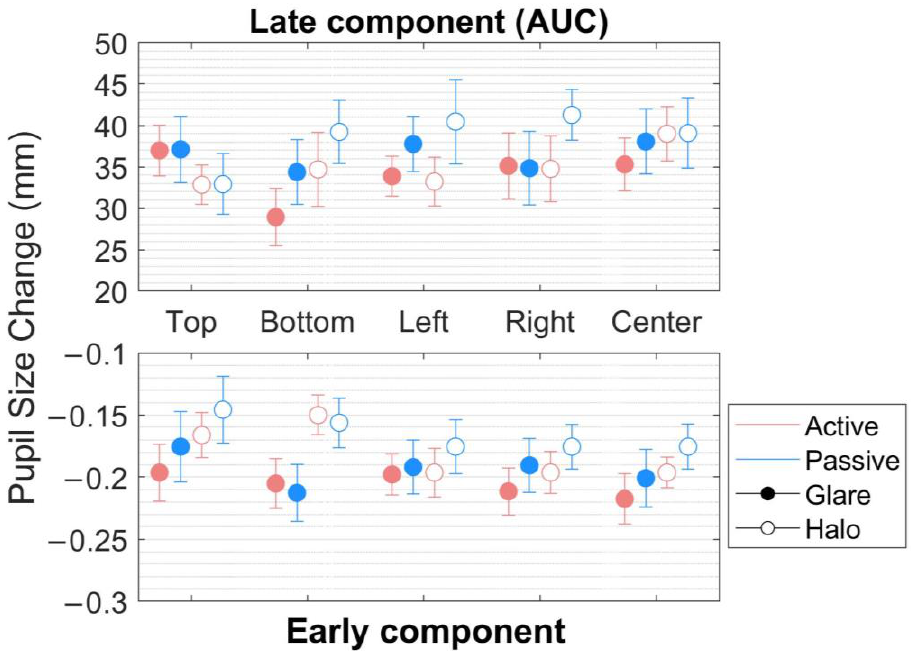
Figure 4. Pupillary response to the glare and halo stimuli in the early component. Pupil diameter changes (mm) in five locations (top, bottom, left, right, and center) in the world-centered coordinates for 20 participants in the active and the passive scenes. Error bars indicate standard errors of the mean.